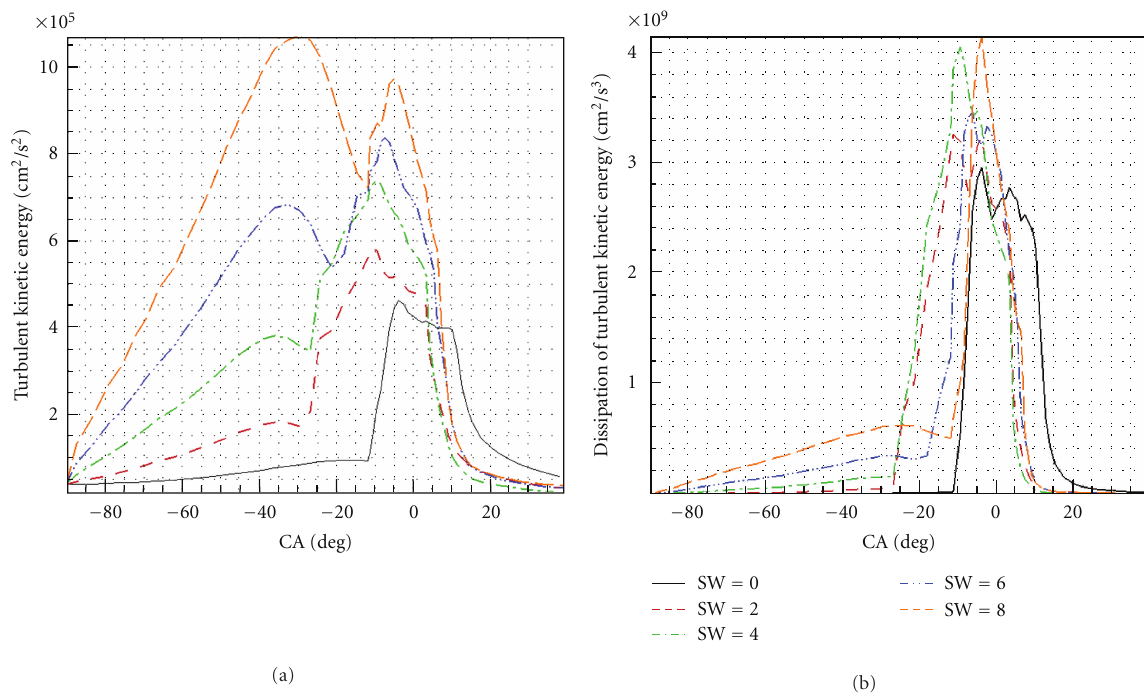
Figure 8: (a) E ff ect of initial swirl ratio on turbulent kinetic energy and (b) e ff ect of initial swirl ratio on dissipation of turbulent kinetic energy, predicted by